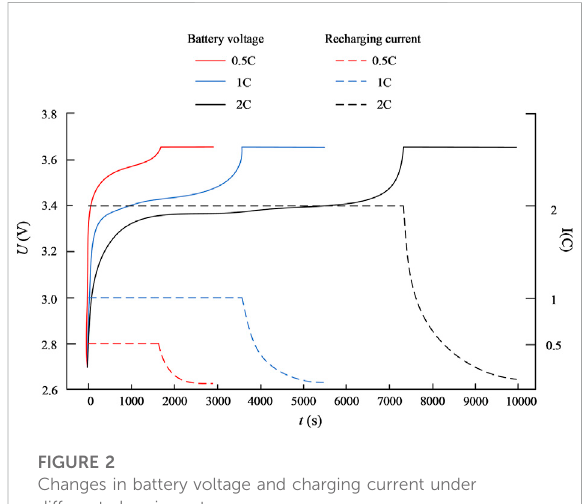
FIGURE 2 Changes in battery voltage and charging current under different charging